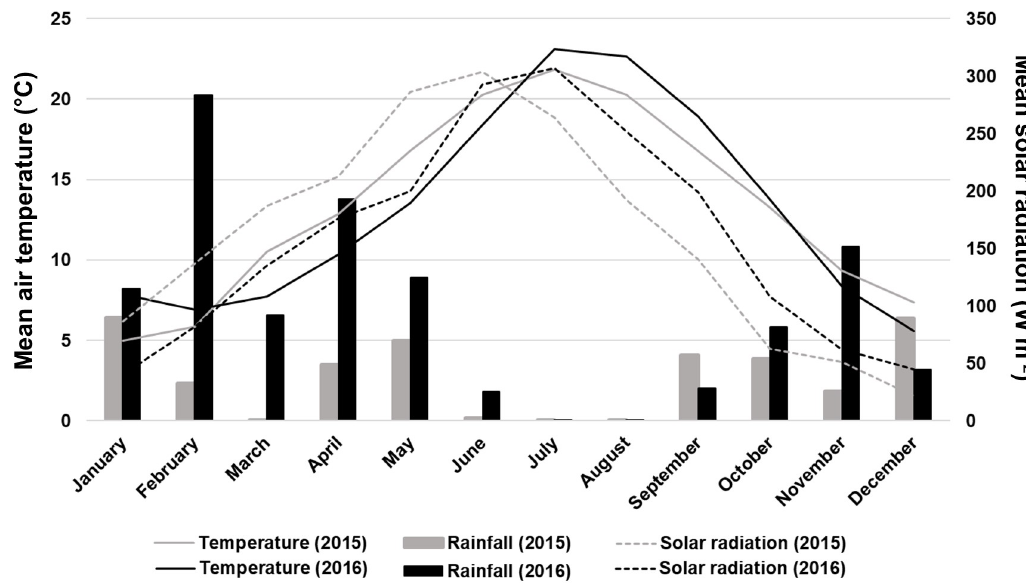
Figure 1. Mean air temperature ( ◦ C), rainfall (mm), and mean solar radiation (W m − 2 ) in 2015 and 2016 measured at Carrazedo de Montenegro.